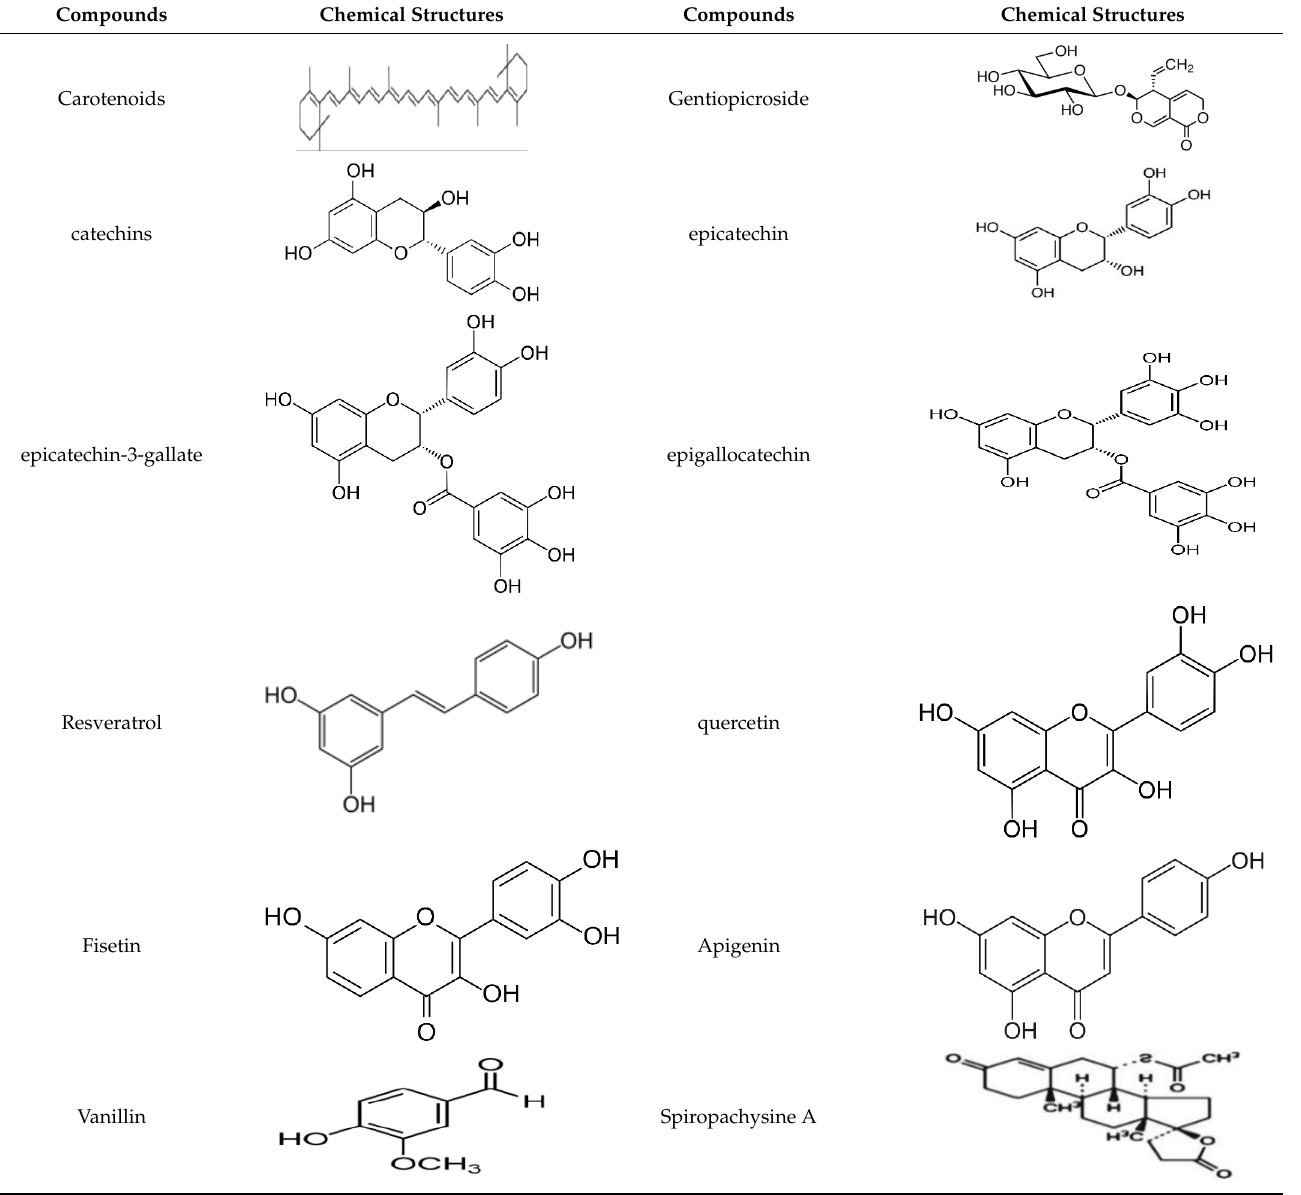
Table 1. The chemical structure of natural compounds.